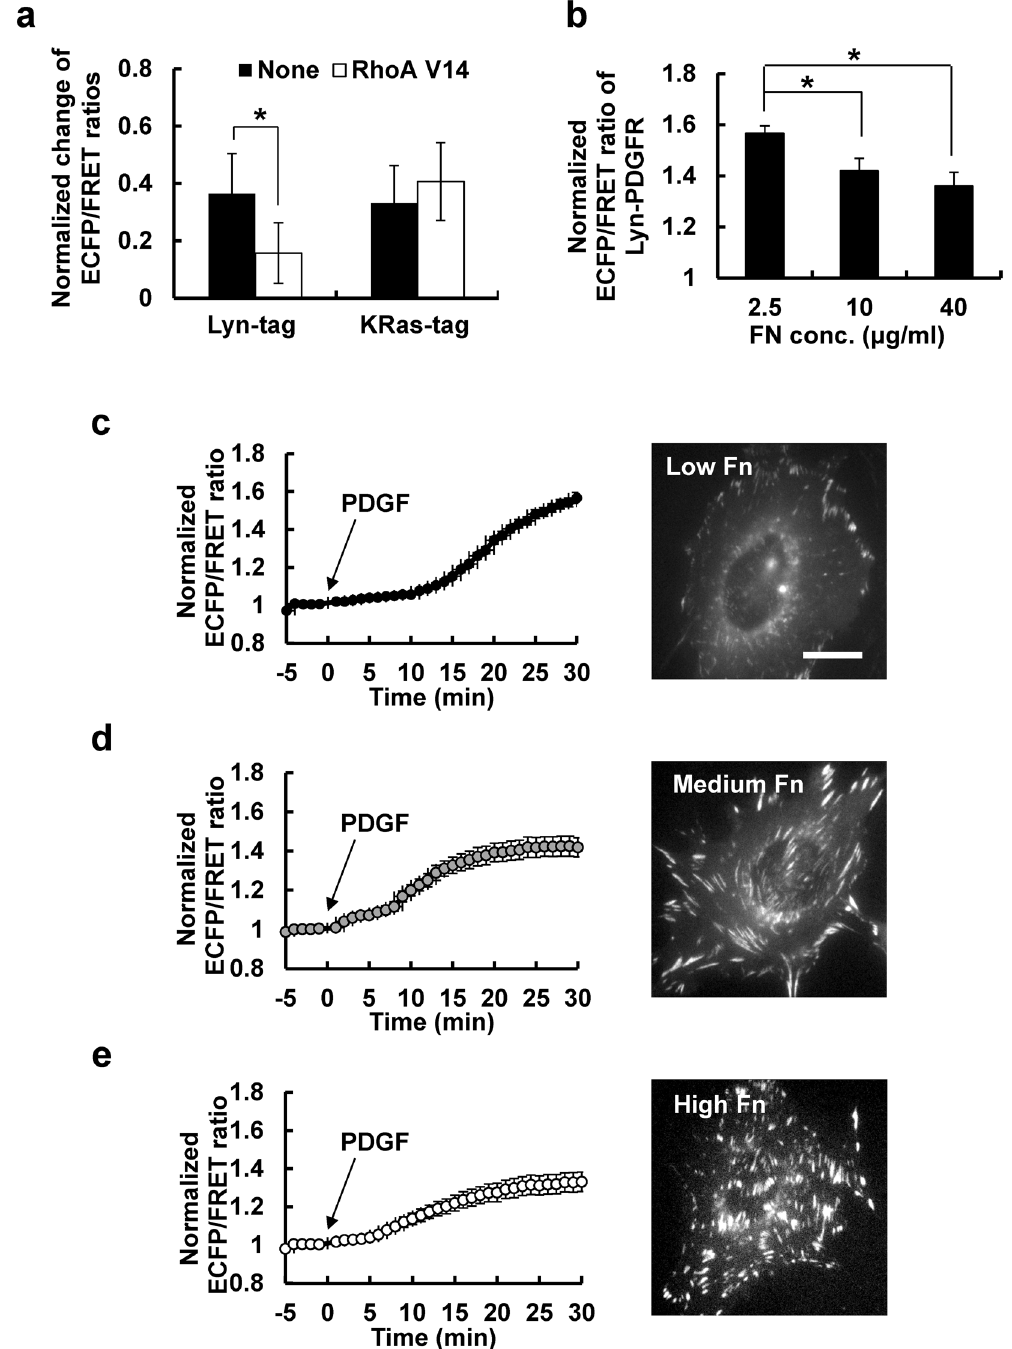
Figure 4. The PDGFR activation in lipid rafts, but not at non-raft membrane regions, is inhibited by integrin/RhoA- mediated cellular tension. ( a ) The normalized ECFP/FRET ratio changes of Lyn- and KRas-PDGFR biosensors with or without RhoA V14 expression in MEFs upon PDGF stimulation. (n = 6) ( b ) The comparison of maximal level of normalized ECFP/FRET ratios (mean ± s.e.m.). (n = 10) ( c – e ) The time courses of the normalized ECFP/ FRET emission ratios of Lyn-PDGFR biosensor in response to PDGF stimulation. MEFs expressing the Lyn-PDGFR biosensor were plated on the dishes coated with different concentrations of fibronectin (Fn): 2.5 μ g/ml ( c ), 10 μ g/ ml ( d ) or 40 μ g/ml ( e ). The representative images of mCherry-tagged paxillin in MEFs cultured on different Fn concentrations are shown on the right. * represents significant difference between groups. (n = 10) Bar = 10 μ